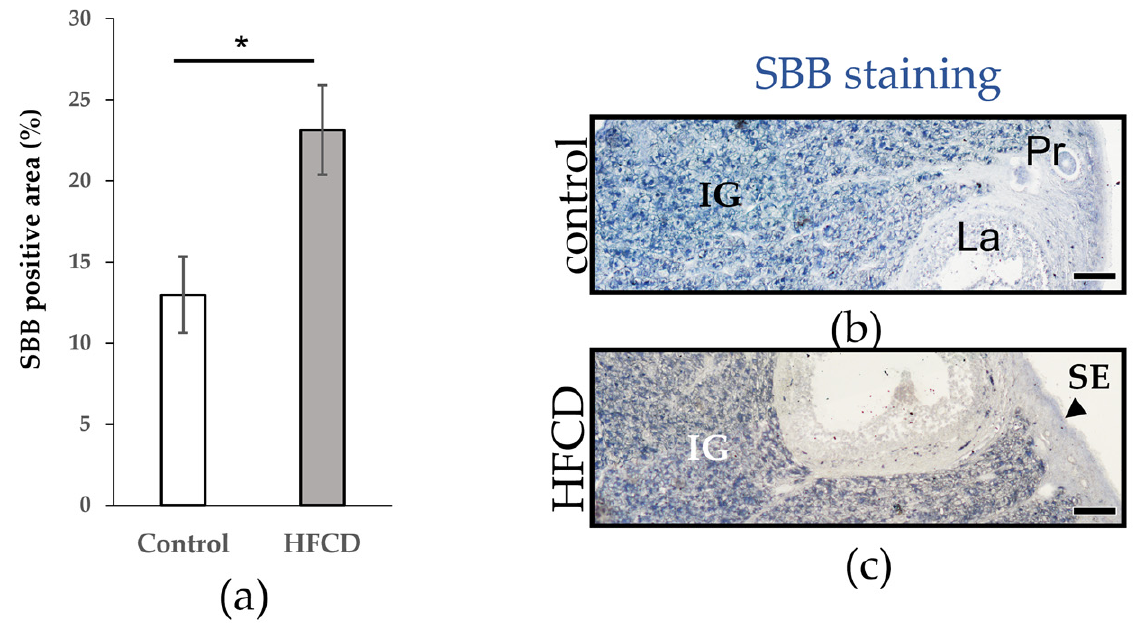
Figure 2. Semiquantification of lipofuscin in the ovarian interstitial gland. ( a ) Semiquantification of lipofuscin was measured as a percentage of the area stained with 0.7% SBB in the ovarian interstitial gland of chinchilla rabbit fed with either a control diet (n = 5) or HFCD (n = 8) * p < 0.05. Vertical bars indicate the standard error of the mean. ( b , c ) Representative SBB staining sections related to the control diet or HFCD. Scale bar: 50 µm. Primary follicle (Pr), Late antral (La), surface epithelium (SE, black arrow), and interstitial gland (IG).